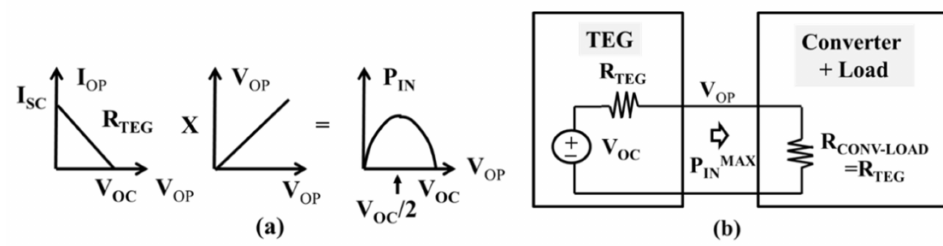
Figure 2. ( a ) I OP and P IN of TEG as a function of V OP and ( b ) equivalent circuit under a maximum- output-power condition with impedance matching.